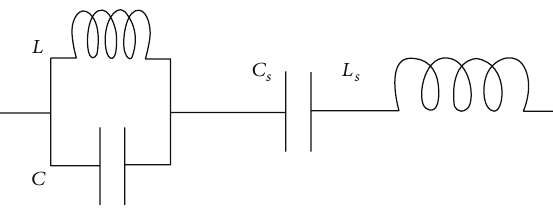
Figure 6: Equivalent circuit model for the LHM